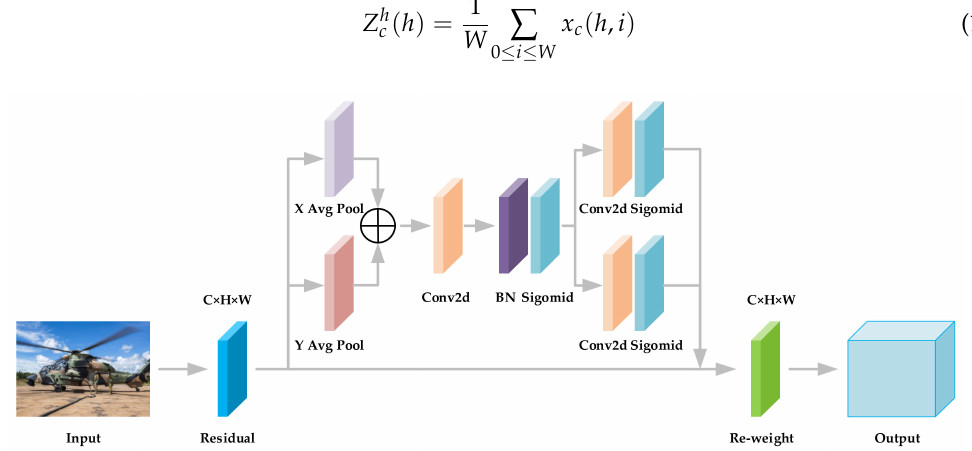
Figure 4. The structure of the Coordinate Attention